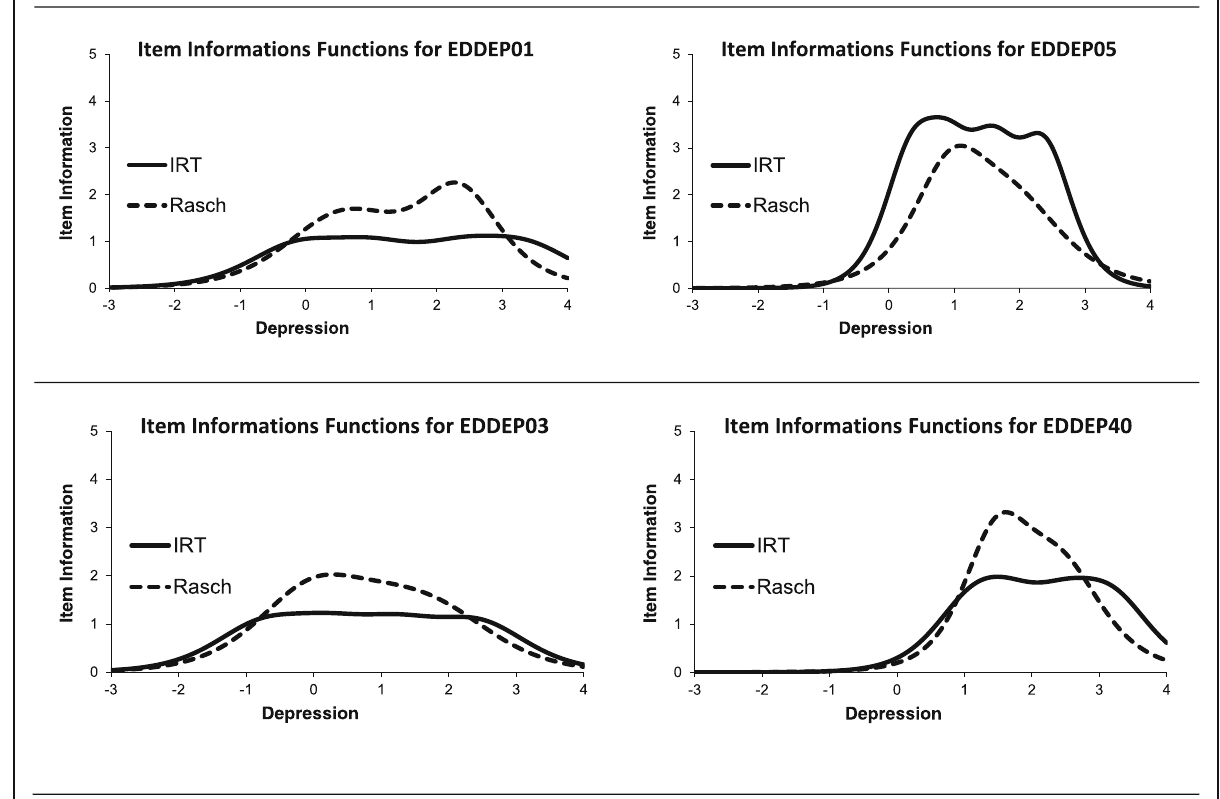
Fig. 6 Item information functions for four depression items according to item response theory and Rasch